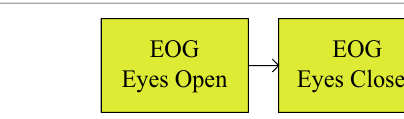
Fig. 1 Timing scheme for each session